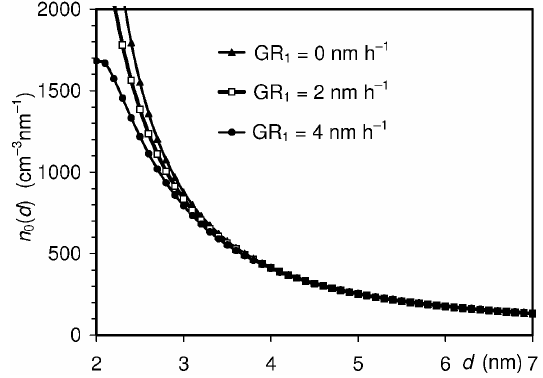
Fig. 2. Size distributions of neutral nanoparticles n 0 ( d ) in case of the near-median distribution of intermediate ions in Tartu (Fig. 1) and N 50–500 = 2000 cm –3 calculated according to Eq. (8) for the trial values of charged nanoparticle growth rate GR 1 .